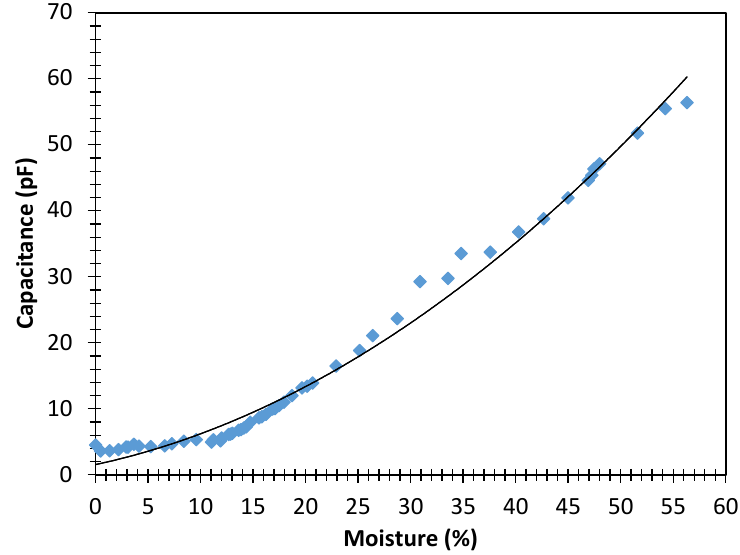
Figure 4. Relationship between capacitance (pF) and moisture content (% according to the standard) of a sample of fresh wood.